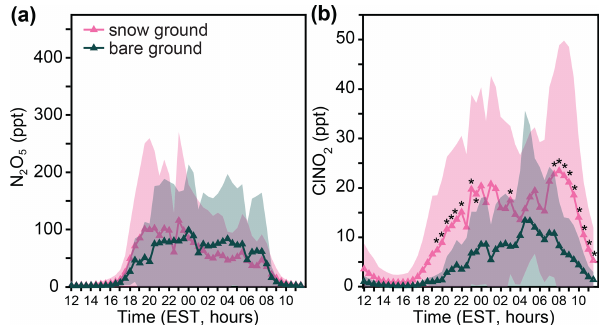
Figure 5. Diel patterns of 30min averaged mole ratios of (a) N 2 O 5 and (b) ClNO 2 binned by snow-covered and bare-ground condi- tions from 20 January to 24 February. Shading represents 1 standard deviation. Asterisks represent statistically significant ( t test) differ- ences at the p < 0.05 level between snow-covered and bare ground for each 30min time period. The ground was snow-covered 57% (20d) of the study and was bare for 43% (15d) of the